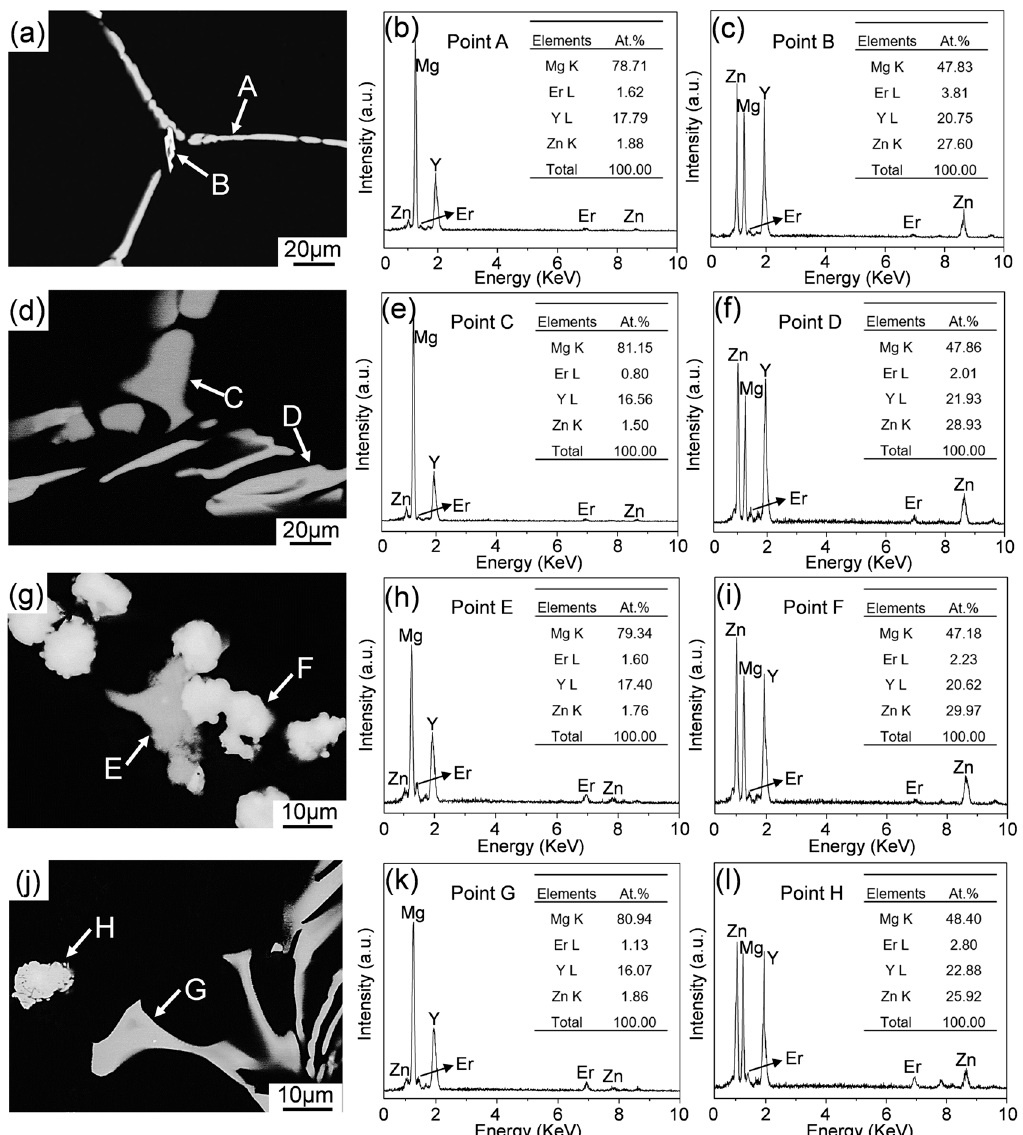
Figure 3. Backscattered electron SEM (BSE-SEM) images and corresponding energy-dispersive spectrometer (EDS) results of the typical intermetallic phases in as-cast alloys: ( a – f ) Mg-11Li-4Y-2Er-2Zn and ( g – l ) Mg-11Li-8Y-4Er-4Zn.